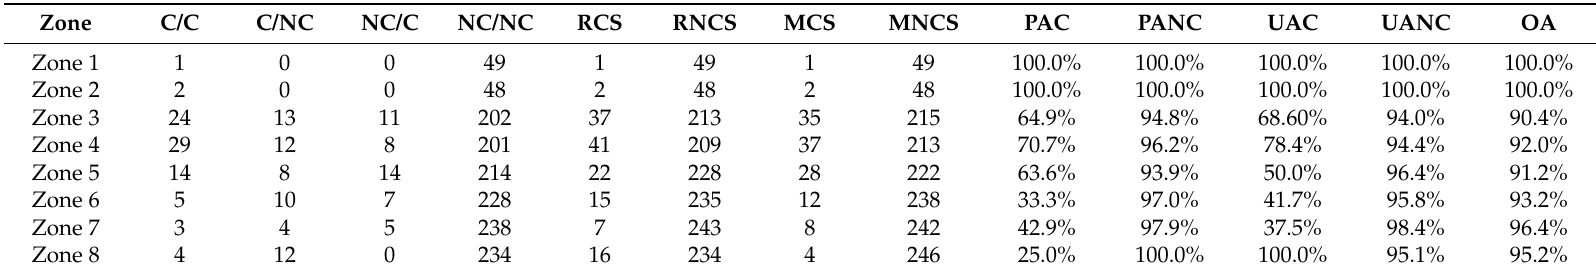
Table 3. Zone-wise accuracy estimates listed for all the AEZ’s in Africa.